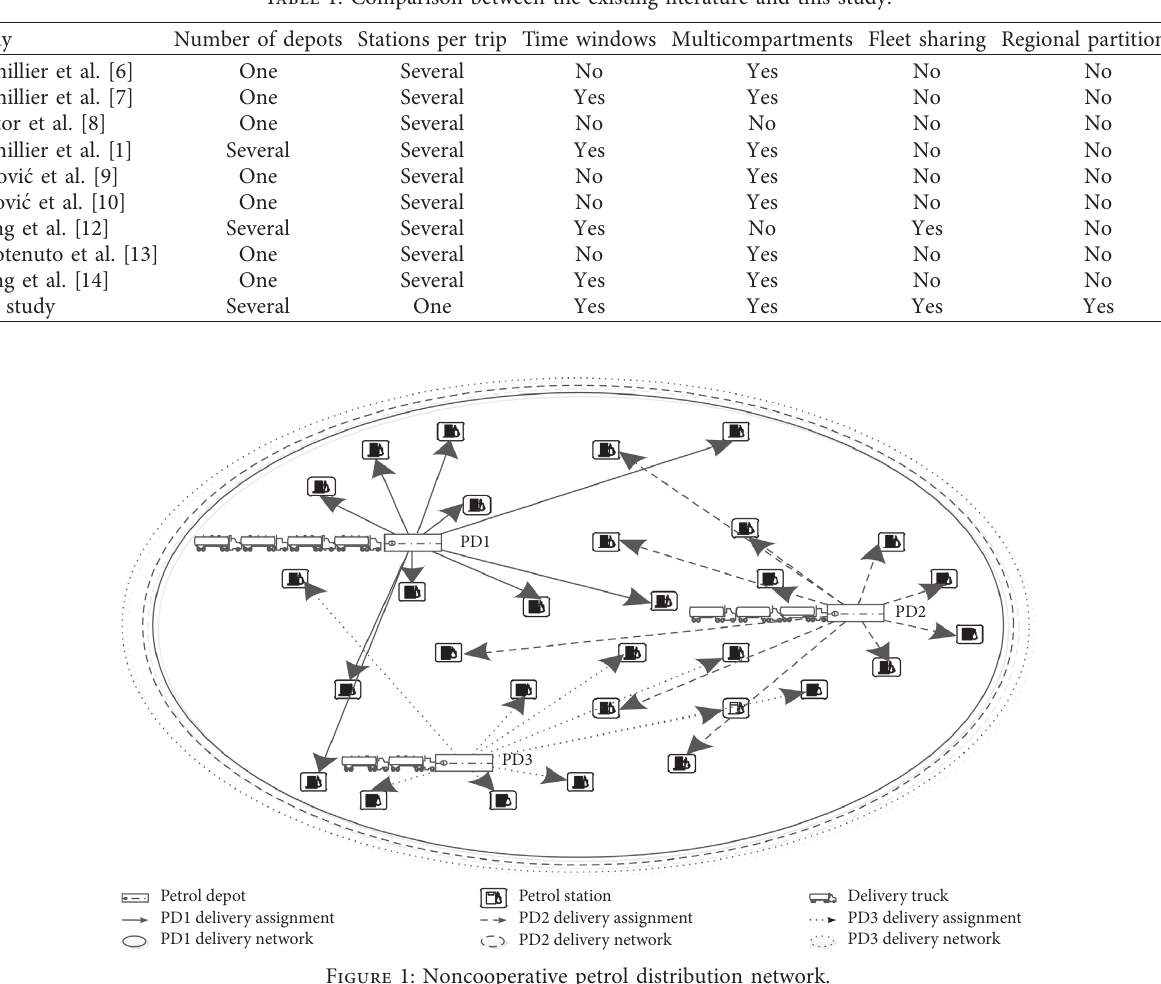
Table 1: Comparison between the existing literature and this study.